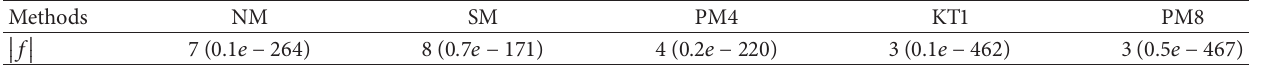
Table 3: Results of comparisons for different methods in solving 𝑓(𝑇) = 0